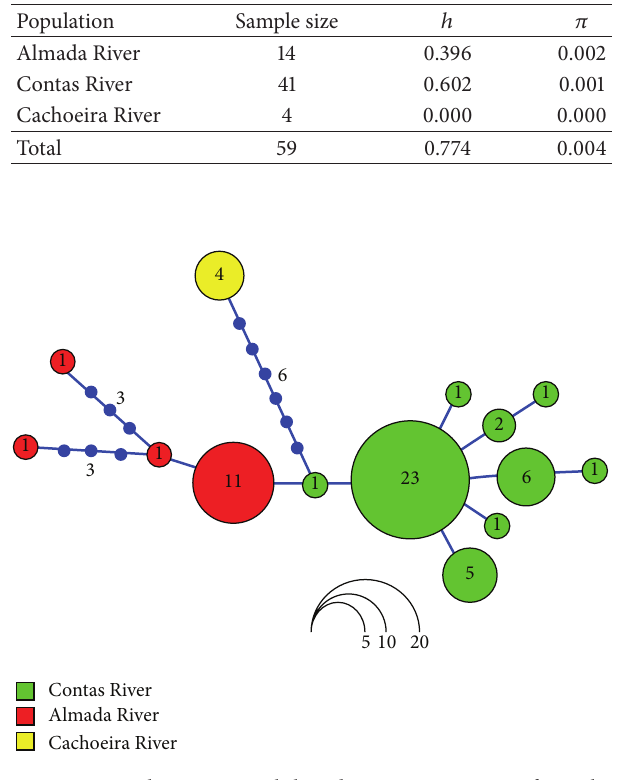
Figure 3: Haplotype network based on COI sequences from the populations of L. myersi (Contas, Almada, and Cachoeira River basins). Each color represents a river basin and the circle size is equivalent to the number of individuals (shown inside the circles) sharing the same haplotype. The values on each line indicate the number of